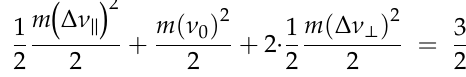
τ ∼ 1.4 × 10 − 11 s M 1 (cid:82) f ( ν ) ν 2 d ν = 1/4 π